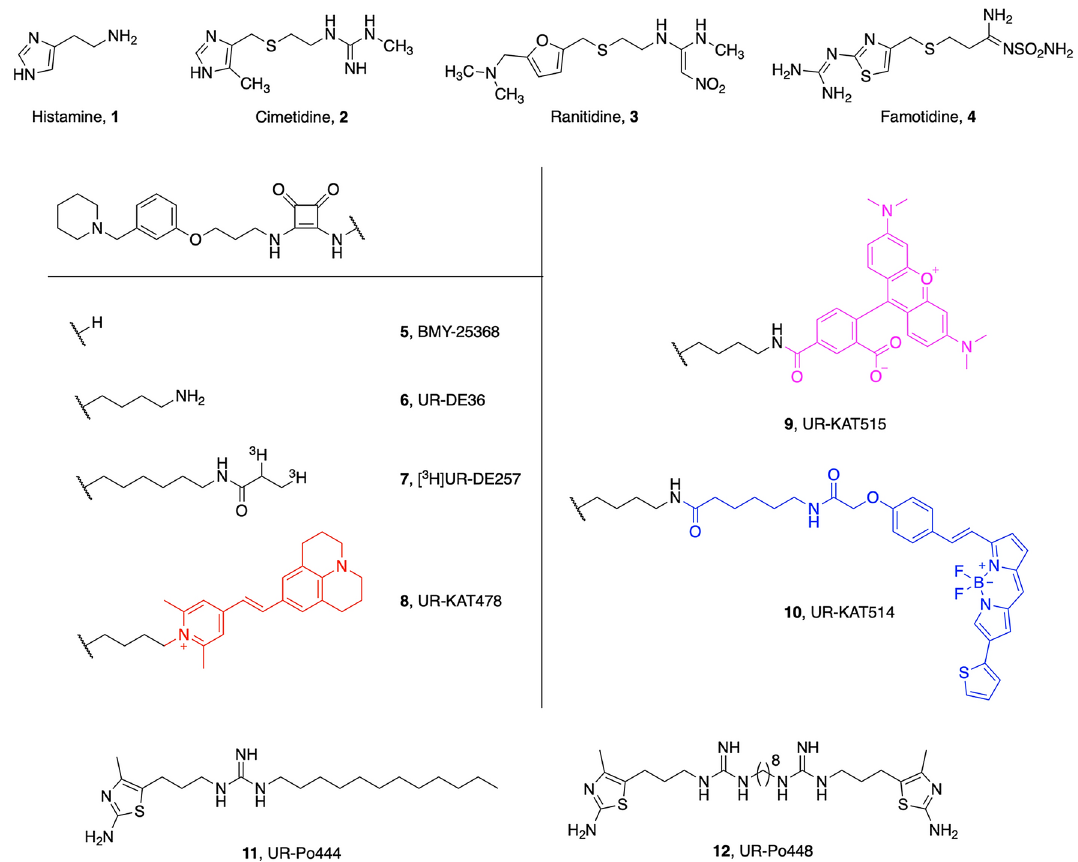
Figure 1. Structures of reported reference compounds ( 1 – 7 , 11 – 12 ) and the synthesized fluorescent ligands 8 – 10 for the histamine H 2 receptor.